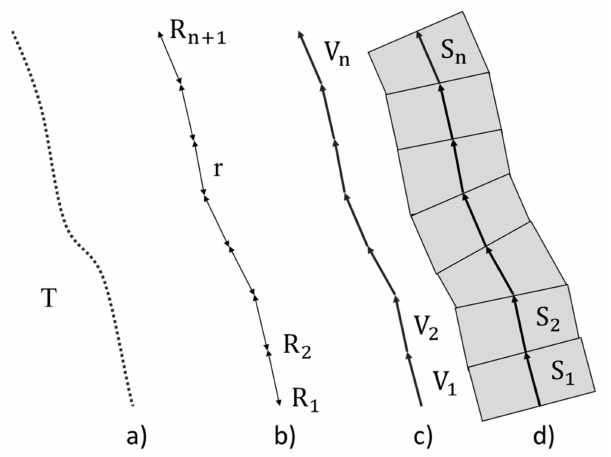
Figure 3. Road segmentation in stretches: ( a ) MLS trajectory points during acquisition, ( b ) selected points each distance r, ( c ) trajectory vectors, ( d ) areas of point cloud associated with each